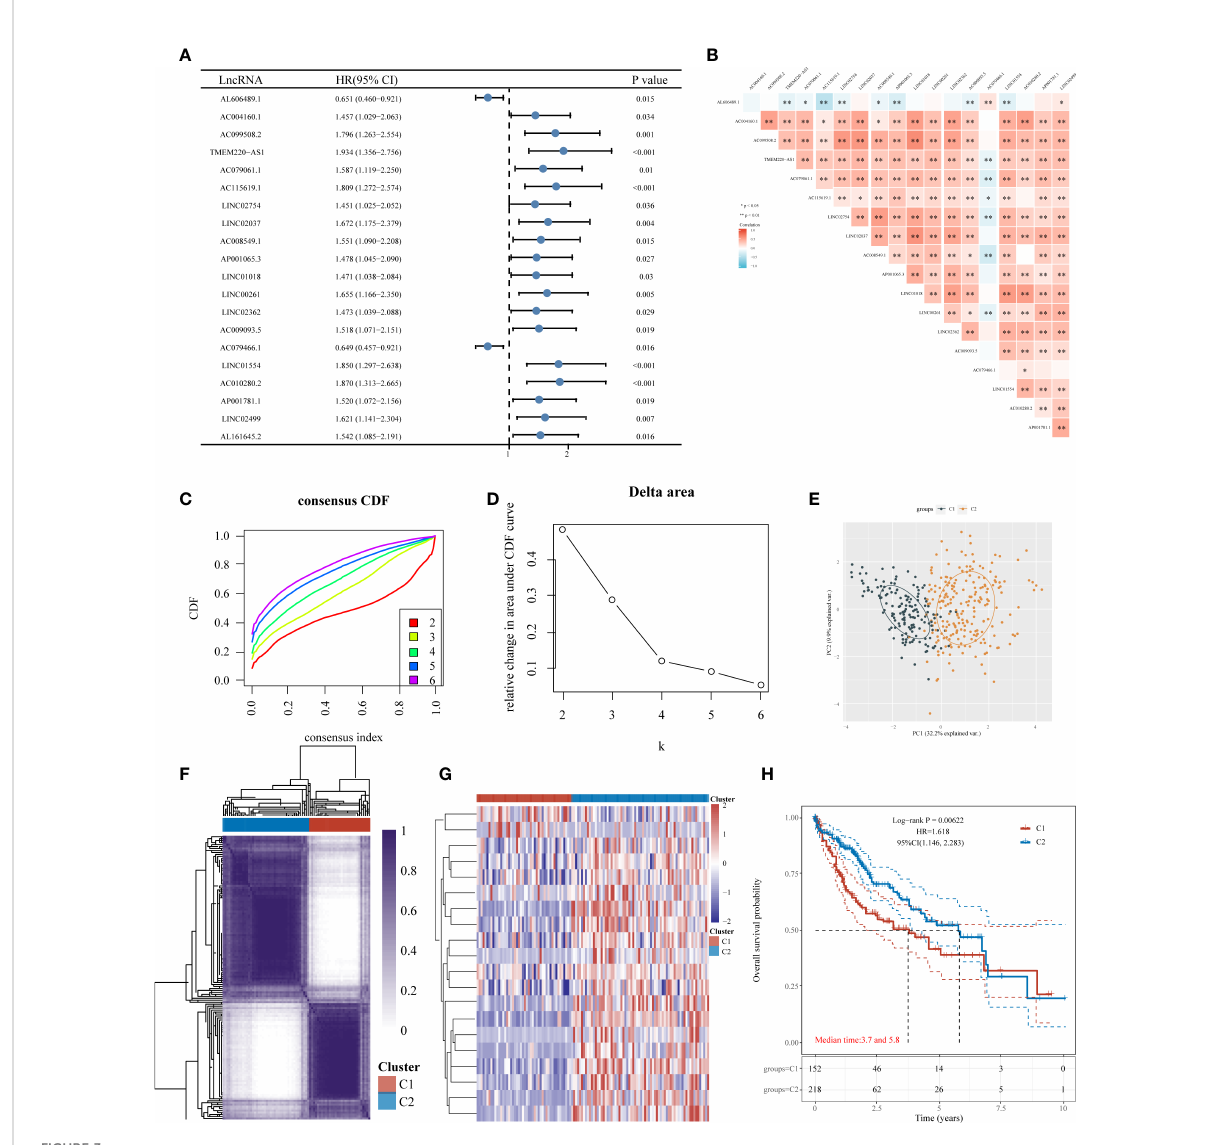
FIGURE 3 Consensus clustering of HCC molecular subgroups based on IICDLs. (A) Forest plot of 20 prognostic IICDLs using univariate Cox analysis. (B) Correlations between the 20 genes. CDF curve (C) , delta area curve (D) , PCA plot (E) , and heat map (F) of consensus clustering. (G) Heat map of IICDL expression in different subtypes. (H) KM survival curve of various subgroups in TCGA data sets. CDF, cumulative distribution function; PCA, principal component analysis; KM, Kaplan – Meier. (*P < 0.05; **P <